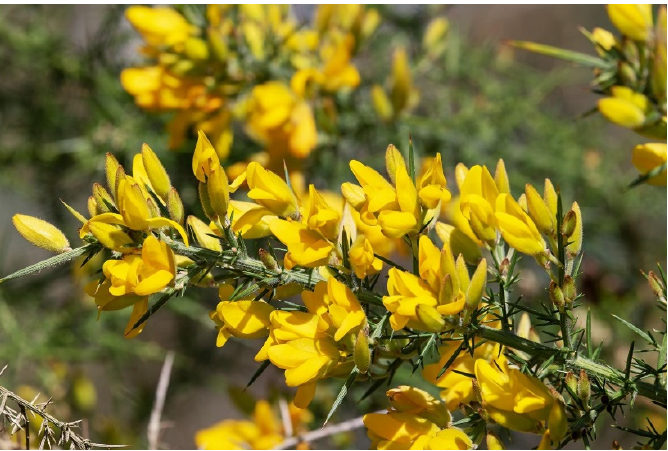
Figure 1. A gorse plant in full blossom.